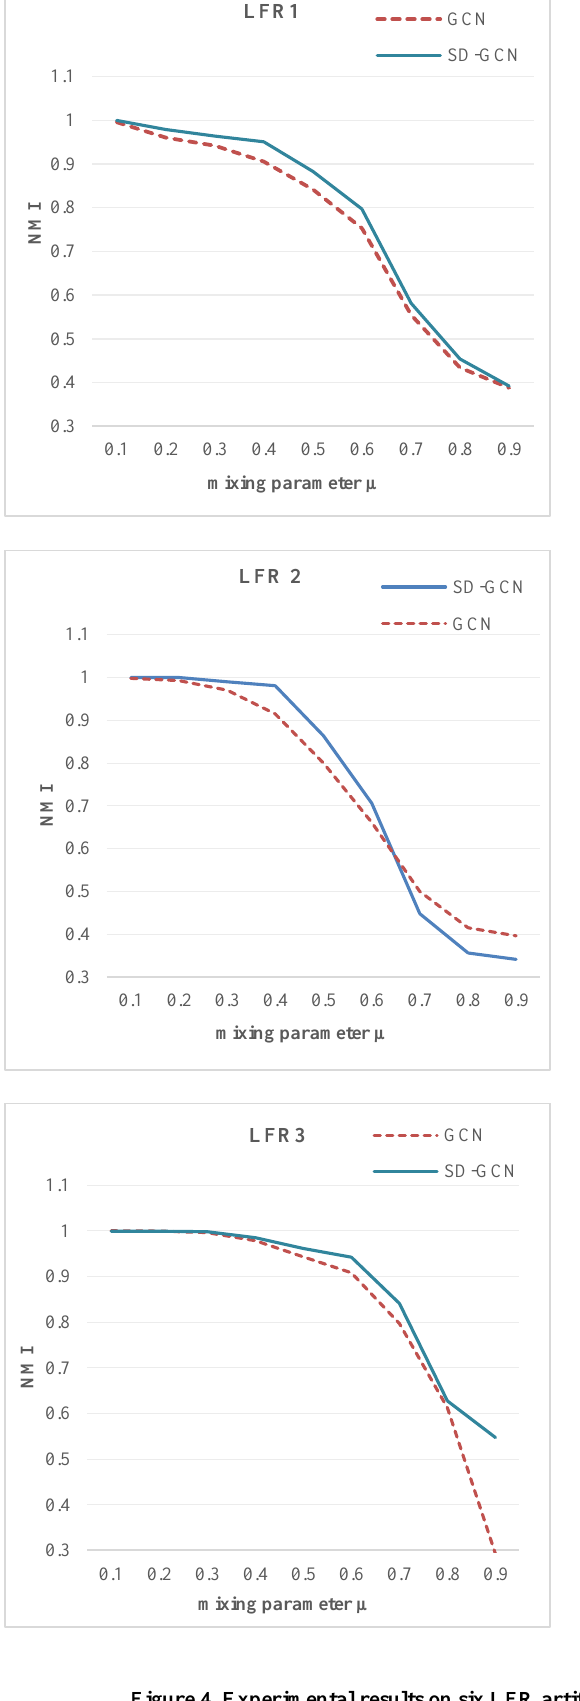
Figure 4. Experimental results on six LFR artificial networks for the SD-GCN and G-CN